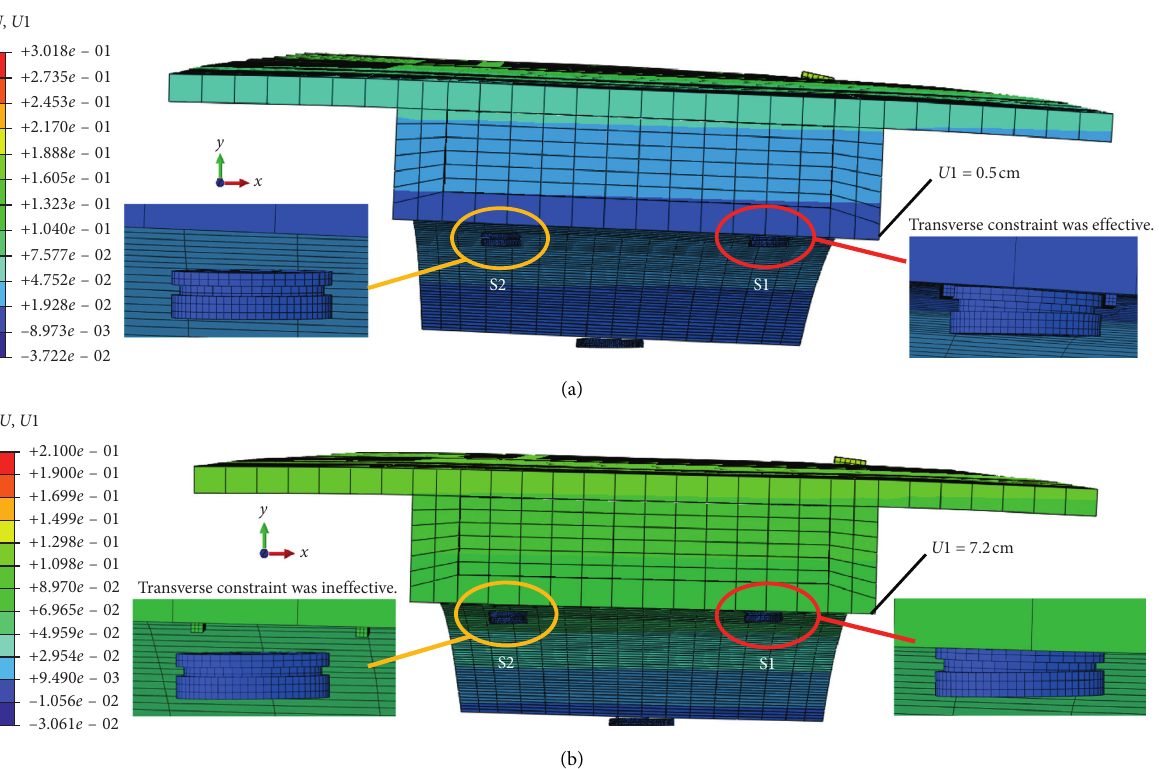
Figure 14: The state of the end bearings in the models at ultimate failure. (a) The original model. (b) The reference model.